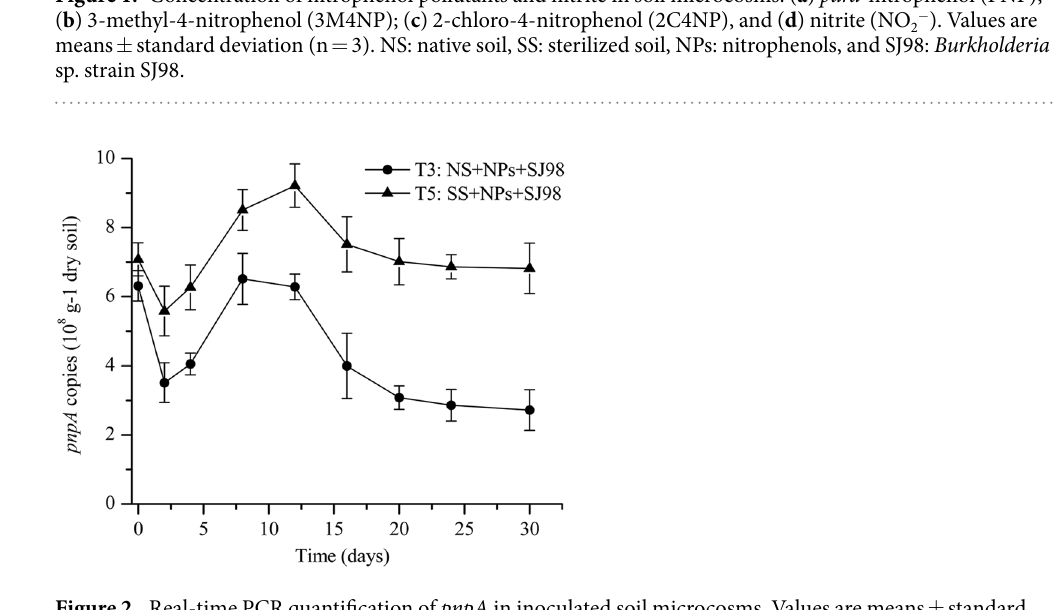
Figure 2. Real-time PCR quantification of pnpA in inoculated soil microcosms. Values are means ± standard deviation (n = 3). NS: native soil, SS: sterilized soil, NPs: nitrophenols, and SJ98: Burkholderia sp. strain